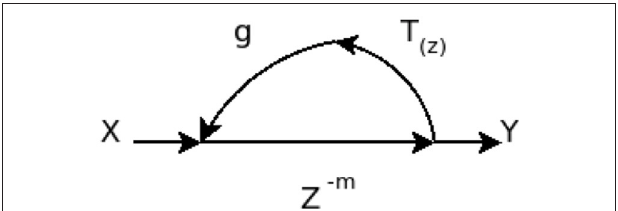
FIGURE 3 | KS-like algorithm in which audio recirculates between two hosts. The SFD software, Figure 2 , has been modified on both sides to include audio loopback and a loop filter (not shown). Aka “SoundWIRE” for Sound Waves on the Internet from Real-time Echoes, this circuit can be excited or “plucked” to sound like a guitar